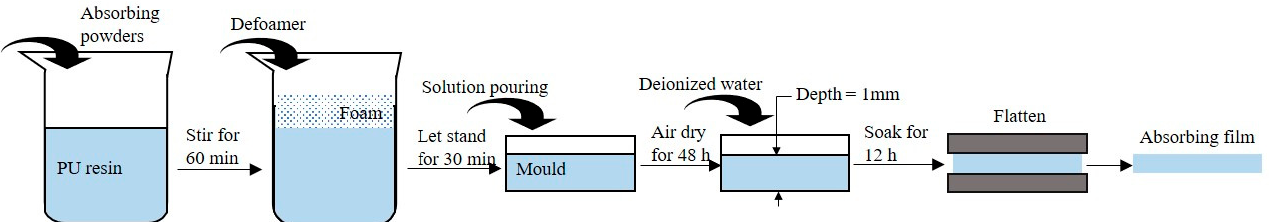
Figure 1. The preparation process of the microwave-absorbing film.